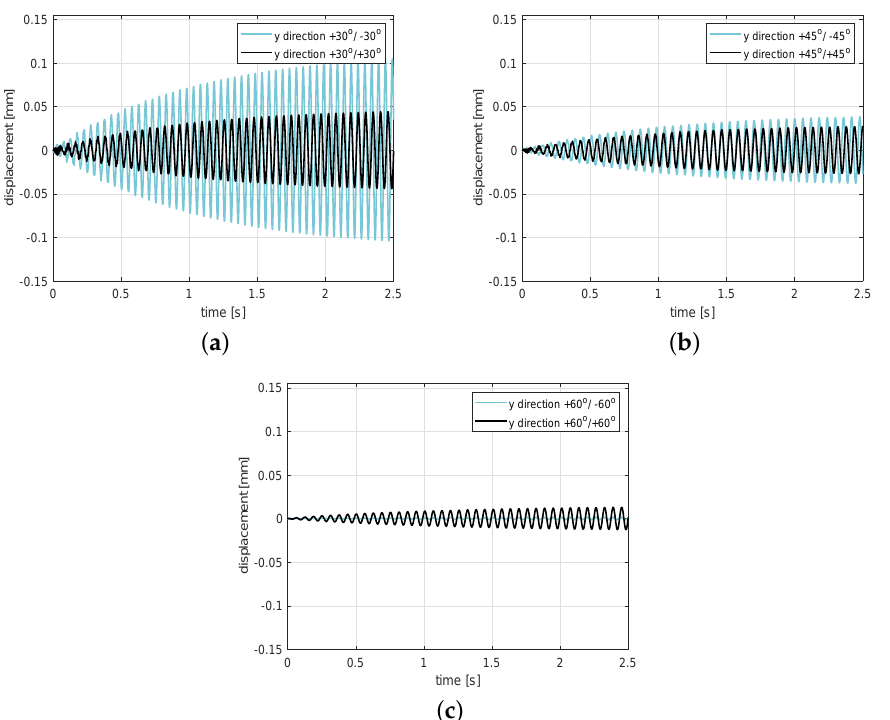
Figure 2. Magnified response of the composite beam after transient time at resonance frequency excitation with excitation amplitude A exc = 1 mm for 30 ◦ ( a ), 45 ◦ ( b ), and ( c ) 60 ◦ layer stacking sequences, respectively. (Details in [30]).